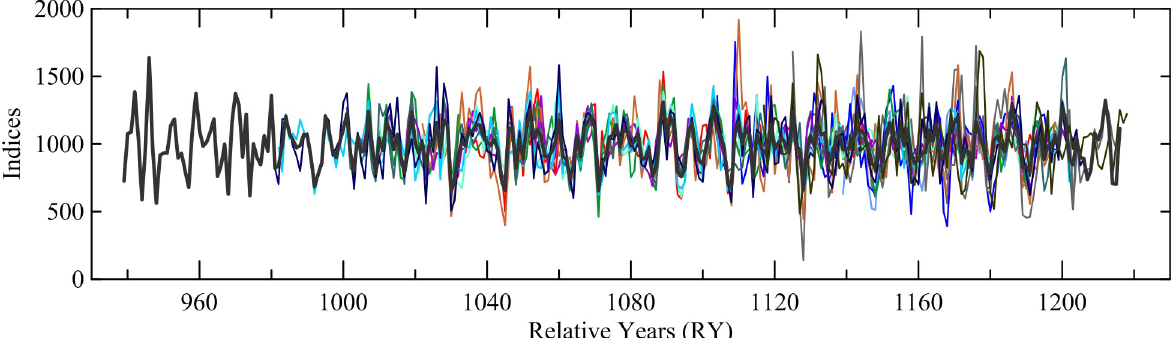
Fig 12. The combined Noceto tree-ring width chronology comprising 14 constituent elements.